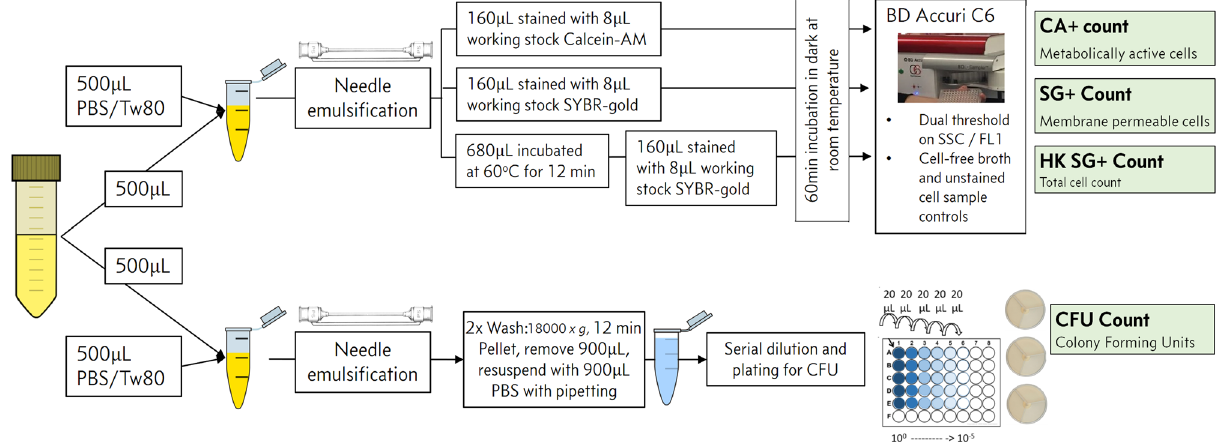
Figure 6. Schematic for final FCM count SOP used in M. bovis BCG culture growth & time-kill dynamics